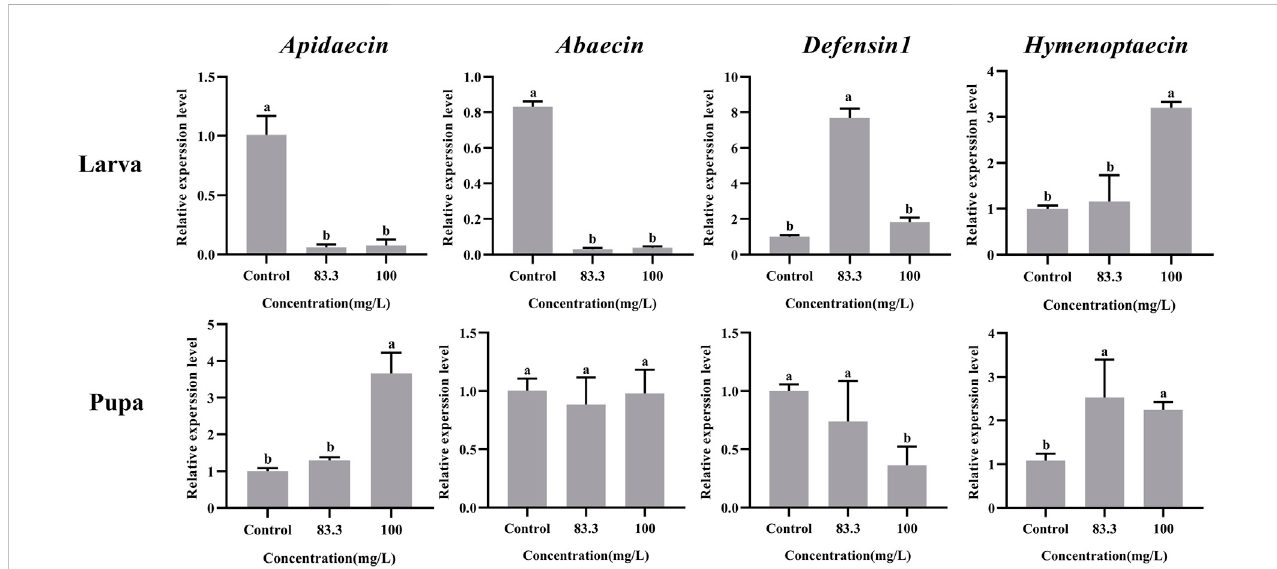
FIGURE 3 Effects of pyraclostrobin on the relative expression of immune-related genes ( Apidaecin , Abaecin , Defensin1, and Hymenoptaecin ) in Apis mellifera larvaeandpupae.Thedatainthe fi guresaremean±SE(standarderror)anddifferentlettersabovebarsmeansigni fi cantdifference( p < 0.05,Fisher ’